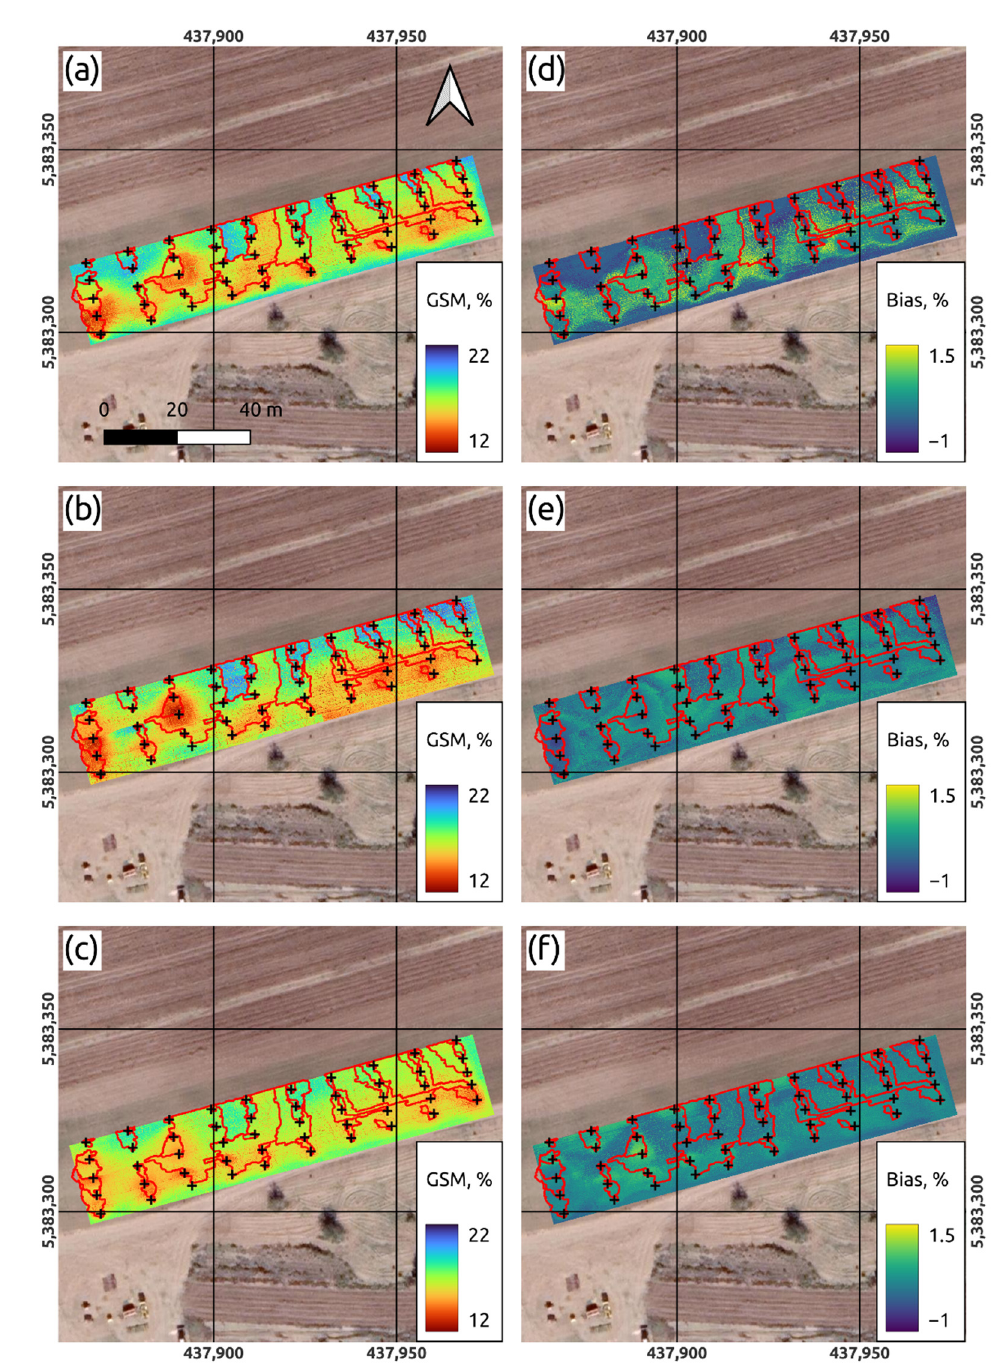
Figure 9. Maps of predicted gravimetric soil moisture (GSM) and their corresponding error maps: ( a ) predicted GSM at depth interval 0–15 cm; ( b ) predicted GSM at depth interval 15–30 cm; ( c ) predicted GSM at depth interval 30–45 cm; ( d ) conditional bias at depth interval 0–15 cm; ( e ) conditional bias at depth interval 15–30 cm; ( f ) prediction conditional bias at depth interval 30–45 cm.